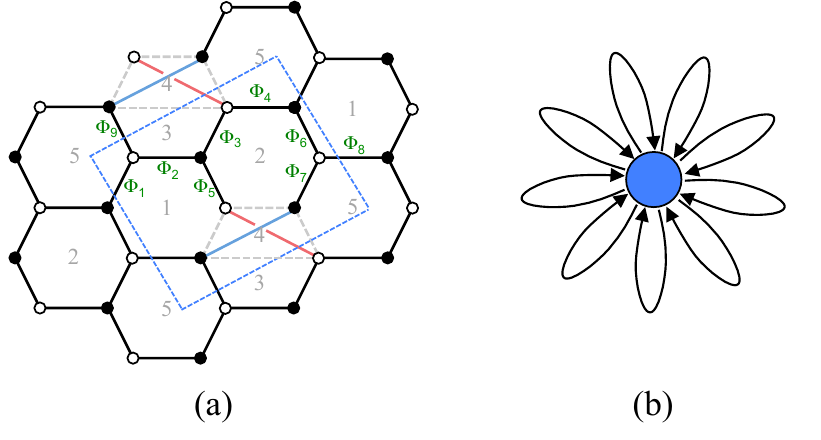
Figure 9. a) Backreaction of an instanton on face 4 of the PdP 2 dimer and b) quiver for the resulting